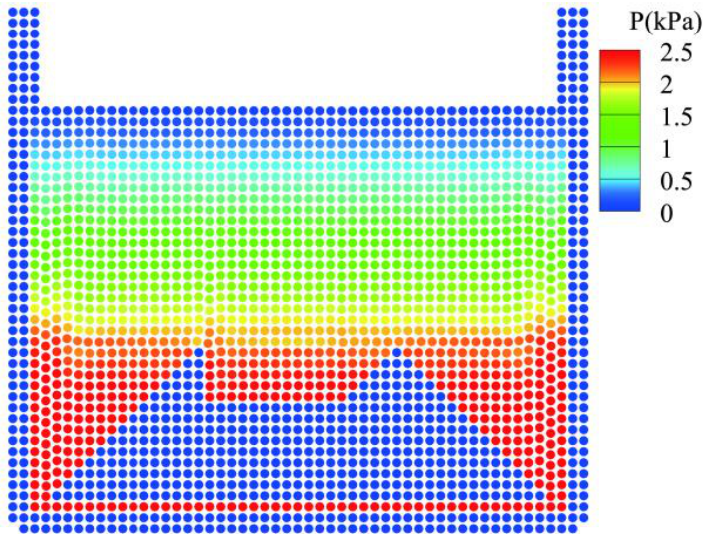
Figure 9. Simulation domain of the hydrostatic calculation in a tank with an irregular bottom. Figure 10 shows the fluid behavior of the hydrostatic simulation in a tank with an irregular bottom using the MPS-SP-CL-V model at t = 3.0 s. It is clear from the figure that the free surface remained flat and the fluid particles in the tank maintained a regular distribution. The pressure distribution was also smooth. Figure 11 shows the time history of the hydrostatic pressure on point S. It is clear that the curve of the MPS-SP-CL-V model was almost consistent with that of the analytical solution. In general, both Figures 10 and 11 indicate that the MPS-SP-CL-V model also reproduced the hydrostatic pressure well when simulating a case with an irregular bottom.